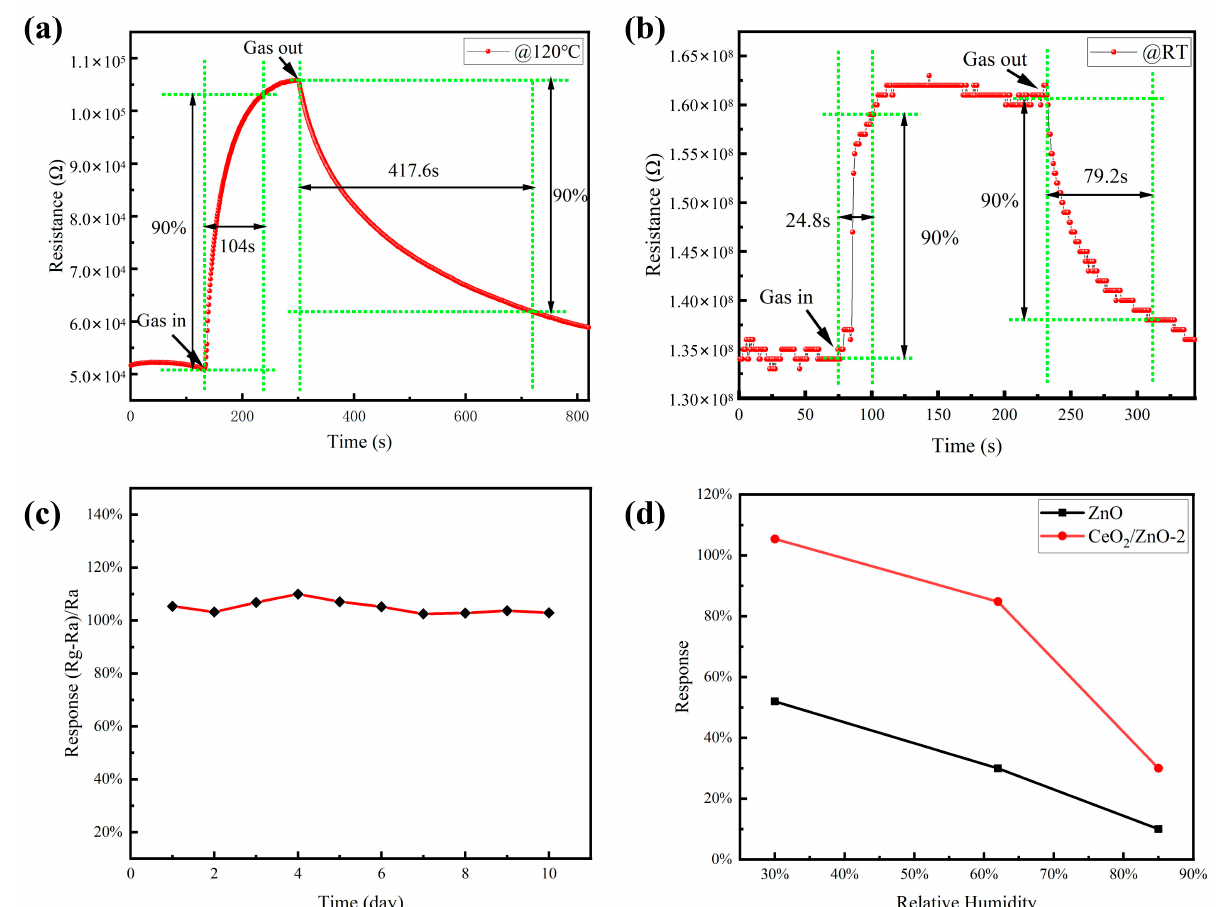
Figure 7. The response/recovery curves of the CeO 2 /ZnO-2-based sensor to 1 ppm NO 2 at 120 ◦ C ( a ) and RT ( b ), respectively. ( c ) The long-term stability of the CeO 2 /ZnO-2-based sensor. ( d ) The response of sensors on different relative humidity levels (30%, 62%, and 85%).